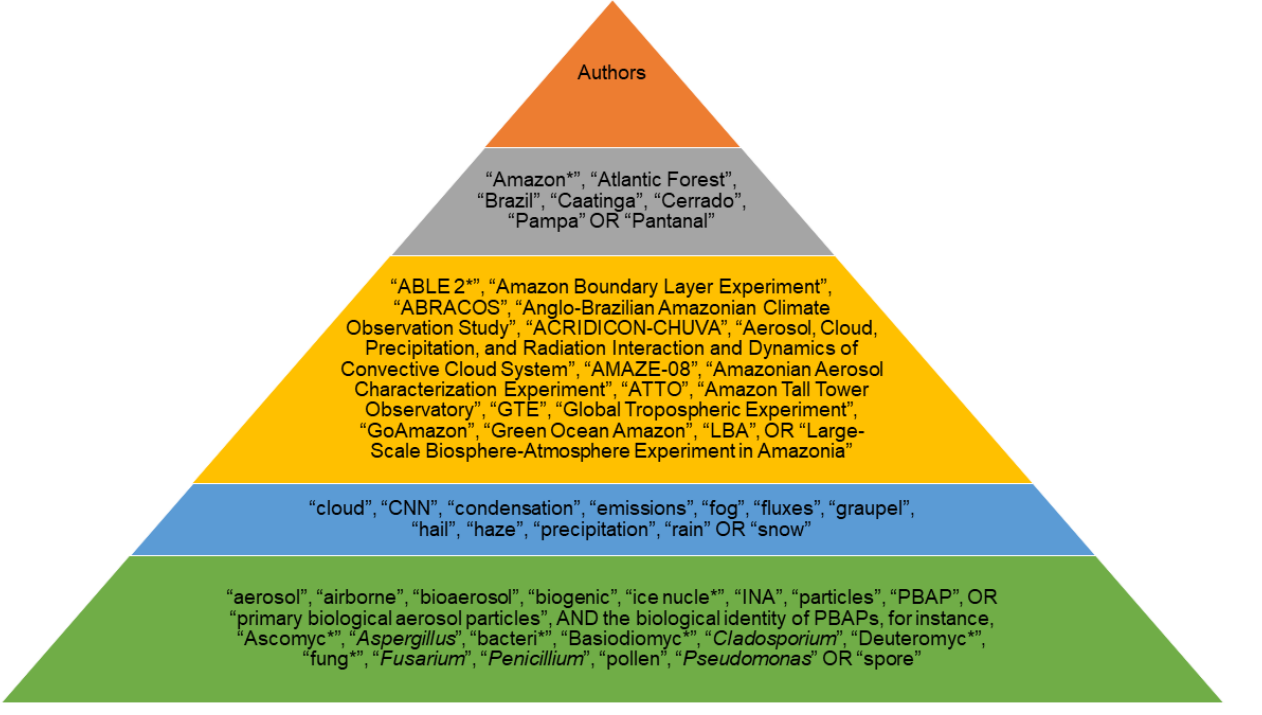
Figure 1. Diagram indicating the keywords and/or small phrases used during the systematic review of the literature on in situ aerosol–PBAP research in Brazil distributed by year of publication, from 1986 until 31 December 2021.